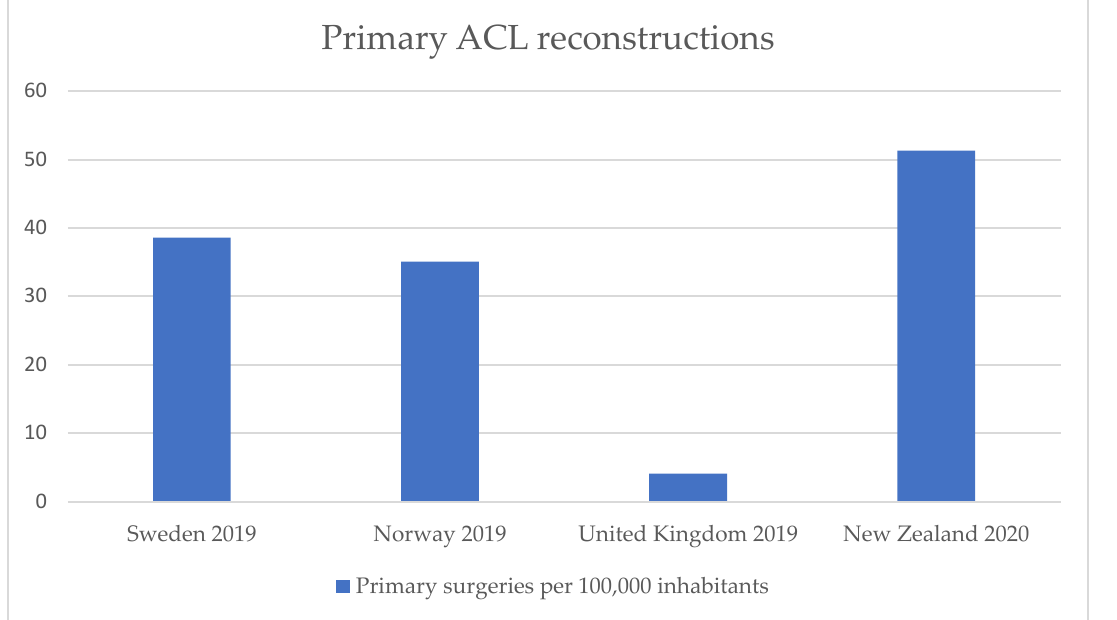
Figure 1. Reported number of annual primary anterior cruciate ligament (ACL) reconstructions per 100,000 inhabitants in different worldwide ACL registers.